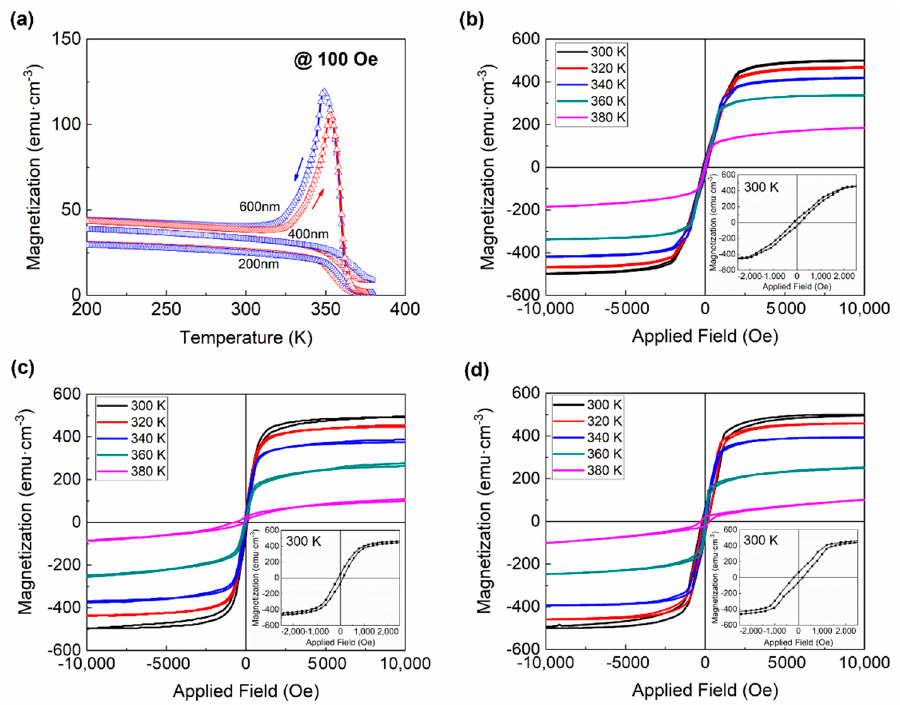
Figure 7. ( a ) Temperature-dependent magnetization cures and ( b – d ). Magnetization hysteresis loops at different temperatures of the Ni 51.0 Mn 27.5 Ga 21.5 thin films. ( b ) 200 nm, ( c ) 400 nm, and ( d ) 600 nm.